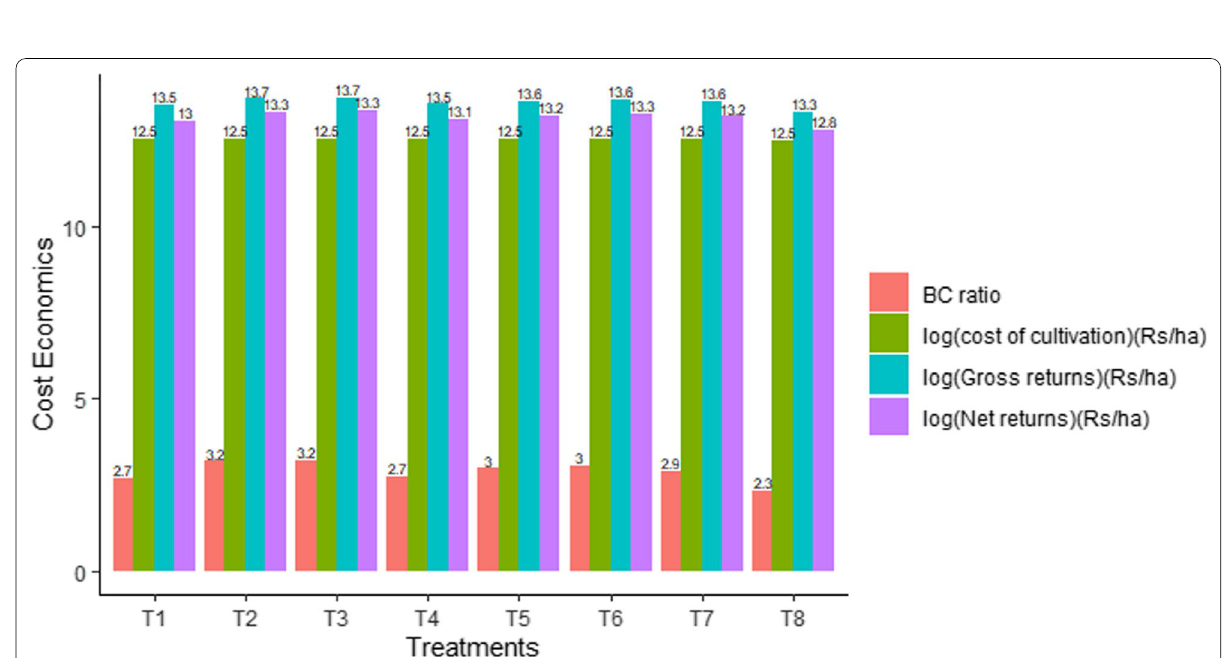
Fig. 3 Cost economics of management of fungal foliar diseases of tomato in a polyhouse condition ( T 1-Seed treatment, seedling dip and spray with T. harzianum; T 2-Seed treatment, seedling dip and spray with B. subtilis ; T 3-Seed treatment, seedling dip and spray with P. fluorescens; T 4-Seed treatment and spray with T. harzianum ; T 5-Seed treatment with T. harzianum and spray with B. subtilis ; T 6-Seed treatment with T. harzianum and spray with P.fluorescens ; T 7-Spray with Sulphur and T 8-Untreated